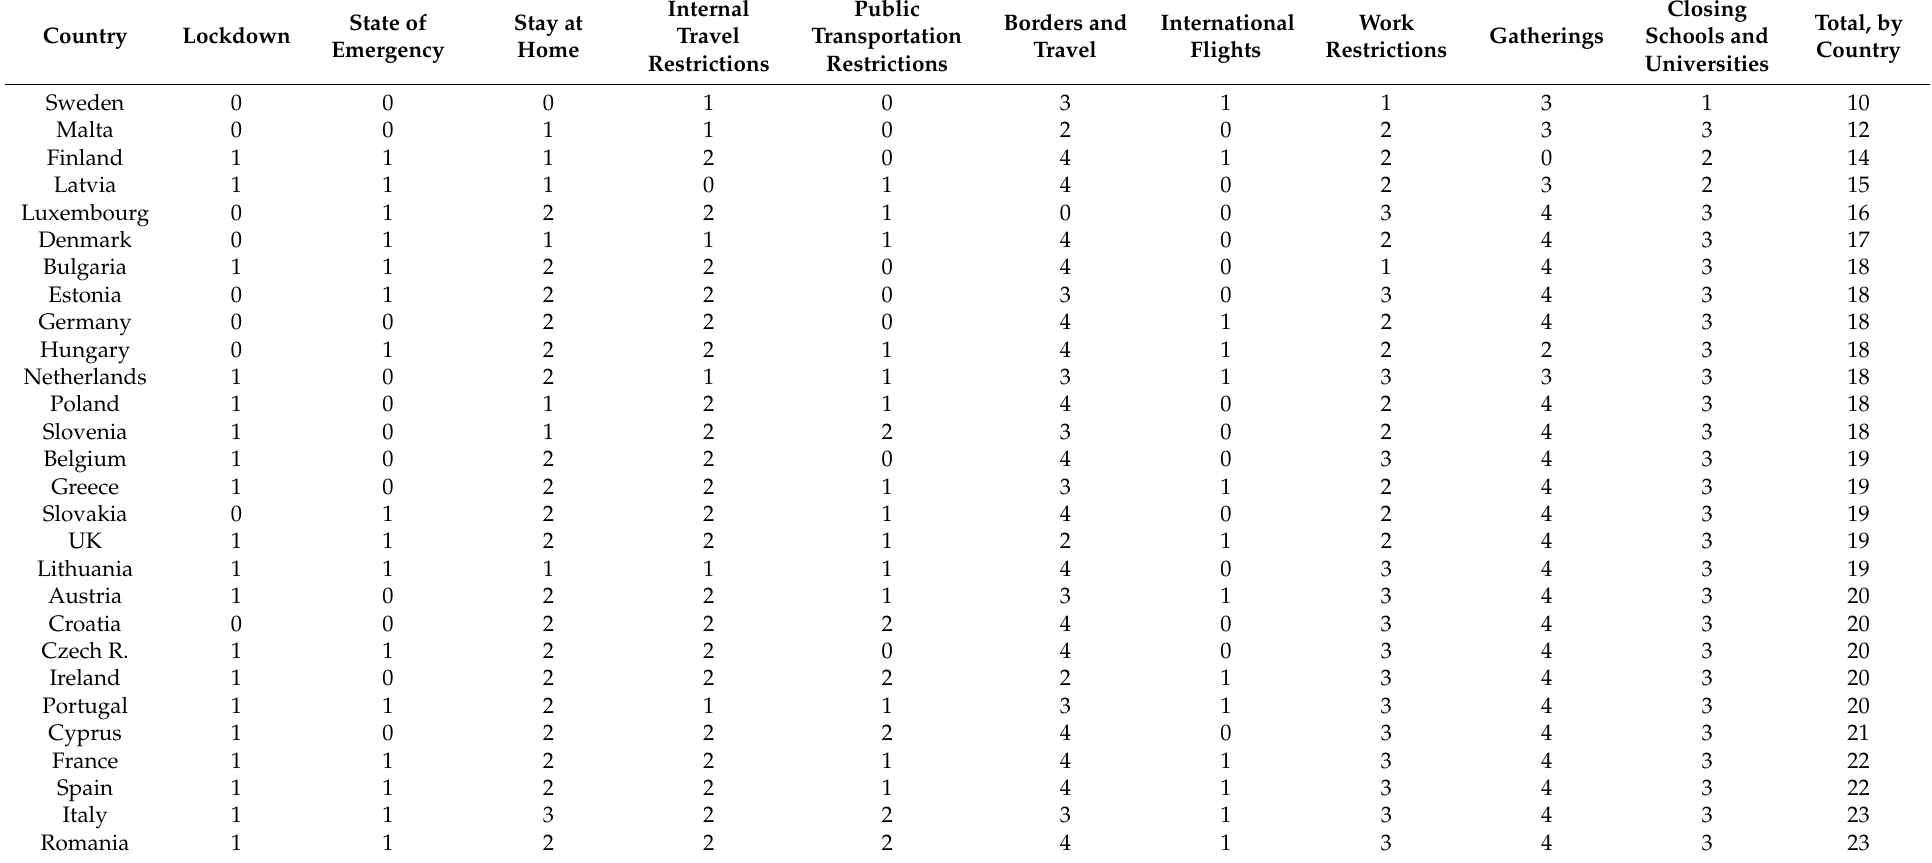
Table 2. Government measures to contain the virus in EU countries (source